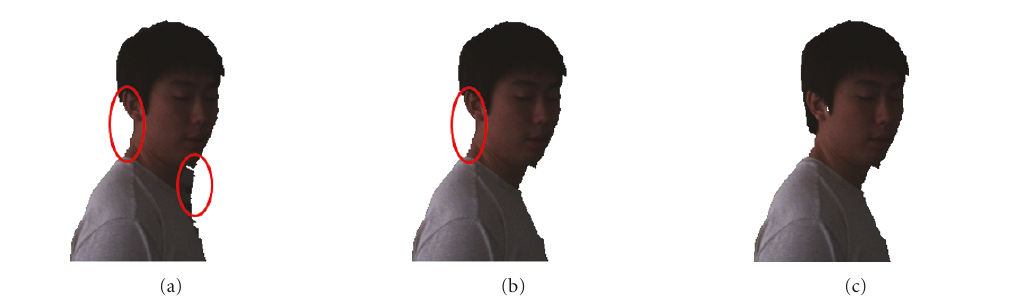
Figure 11: Segmentation results of the proposed algorithm I on the “Moving Object and Background” sequence: (a) sensitivity term only, (b) sensitivity and color terms, and (c) sensitivity, color, and temporal coherence terms.